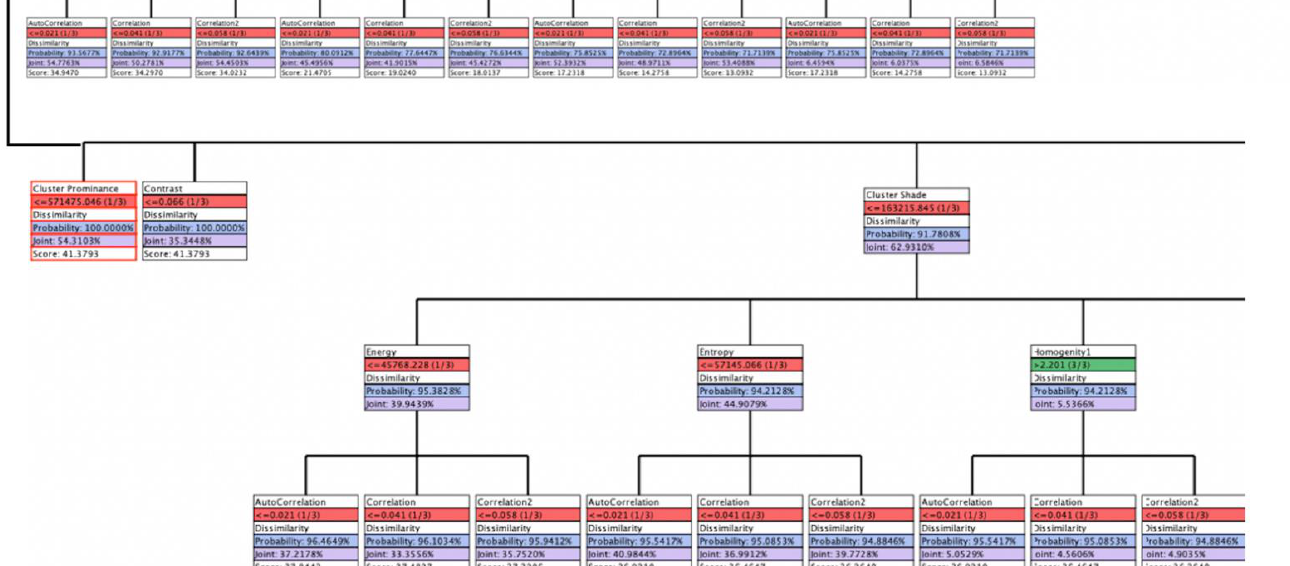
Figure 4. Dynamic tree analysis, based on the selected target node of dissimilarity. At the second level, cluster shades produce child nodes with probabilities such as energy (95.38%), entropy (94.21%), homogenity1 (94.21%), autocorrelation (93.56%), cor- relation (92.91%), and correlation1 (92.64%). Likewise, energy has child nodes of autocor- relation, correlation, and correlation2. Moreover, homogeneity1 has child nodes of auto- correlation, correlation, and correlation2. At the third level, energy, entropy, and homog- enity1 have the child nodes autocorrelation, correlation, and correlation2.